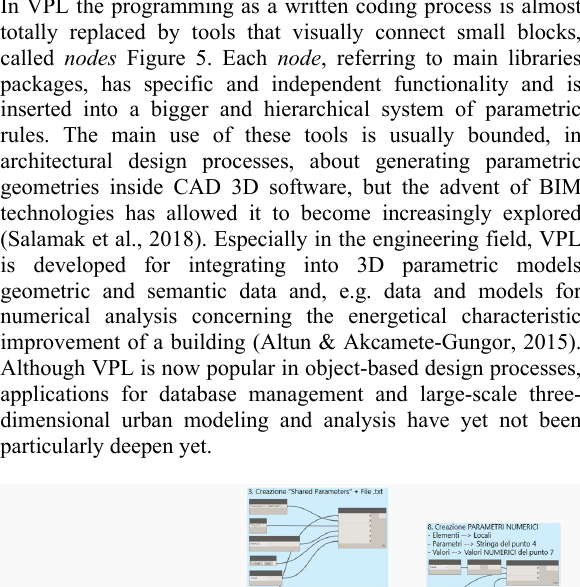
Figure 5. 3D modeling strategy comparison: VPL and programming scripts